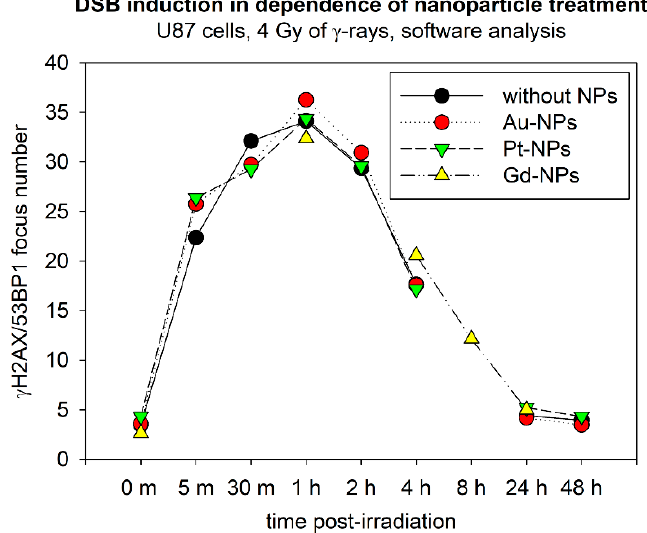
Figure 11. Comparison of γ H2AX/53BP1 focus (DSB) formation and repair in U87 cells irradiated with 4 Gy of γ -rays in absence or presence of 2.6 nm Pt-NPs, 2.4 nm Au-NPs or 2.0 nm Gd-NPs. The results of an automated software analysis are shown as mean numbers of foci per nucleus measured at the indicated periods of time PI. Black circles—without NPs, green triangles—Pt-NPs (0.5 mM, 6 h-incubation), and red circles—Au-NPs (0.5 mM, 6 h-incubation; preliminary results). The data are also compared to our earlier results [21] for Gd-NPs (1 mM for 1 h, 60 Co-irradiation, 4 Gy) (yellow triangles). X-axis: m = minutes, h = hours; 0 min = non-irradiated samples.